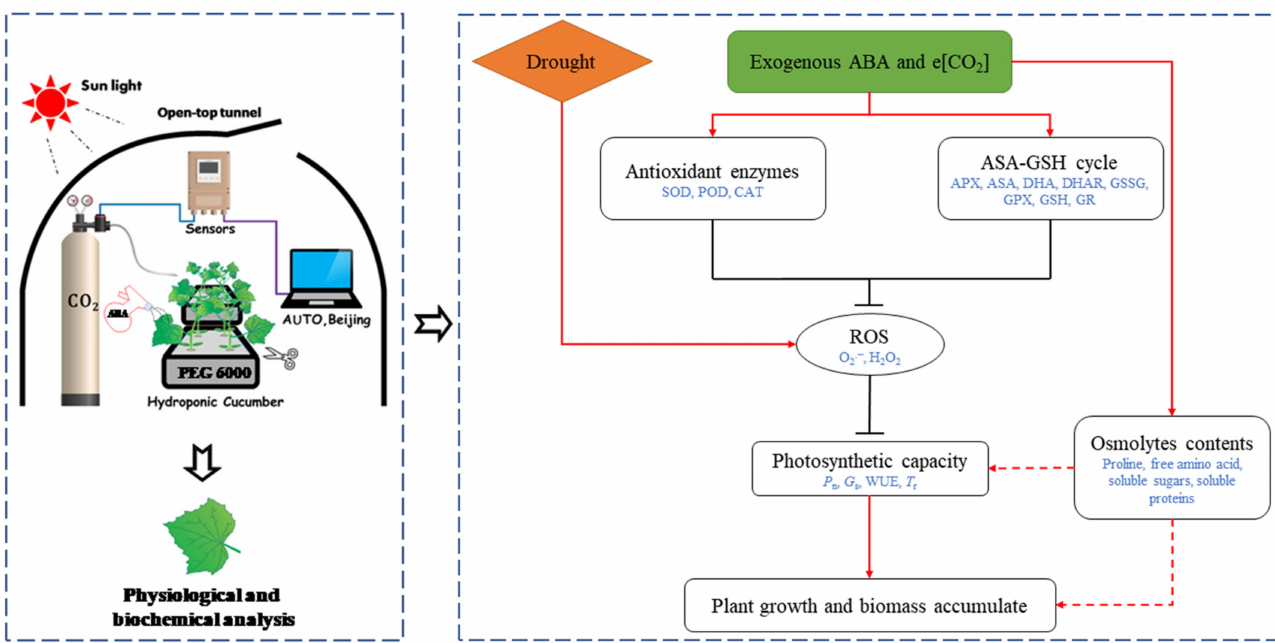
Figure 7. Schematic diagram of elevated CO 2 and exogenous ABA enhancement of drought resistance of cucumber seedlings. Arrow and bar-ended lines represent activation and inhibition, respectively. Dotted lines denote indirect